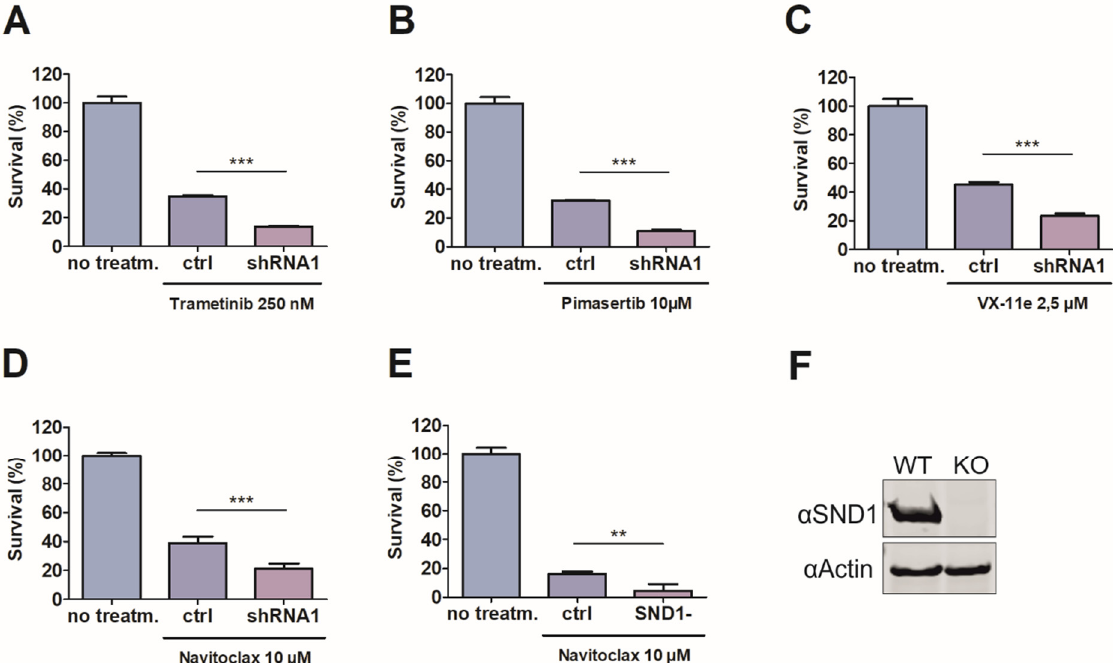
Figure 2. SND1 deficiency sensitizes cancer cells to MEK-ERK pathway inhibitors and Bcl-2 family inhibitor navitoclax. ( A – D ) CellTiter-Glo assay measuring the viability of the cells after indicated drug treatment (72 h) in control and stable, conditionally SND1 silenced cell lines (shRNA1). ( E ) Viability reduction after navitoclax treatment (72 h) in control and CRISPR-Cas9 mediated SND1 knock out cell line. ( F ) Western blot illustrating the absence of SND1 protein in SND1 knock out cell line. Two-tailed t-test was used for statistical analysis. Error bars indicate the standard error of the mean. N = 3, ** = p < 0.01, *** = p < 0.001.